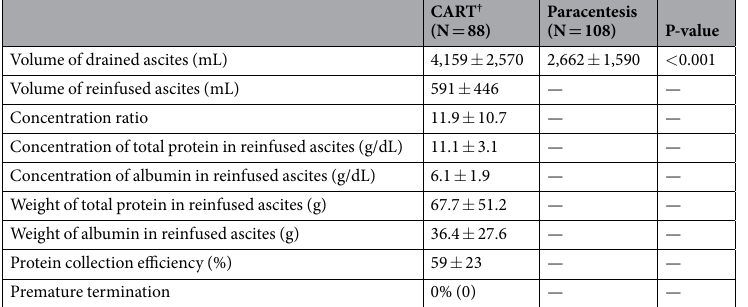
Table 2. Processing conditions of CART and paracentesis. † Low and external pressure type filtration method CART (DC-CART 23 ). Qualitative data, percentage (number). Quantitative data, mean ± SD; P-value was calculated by the Student t